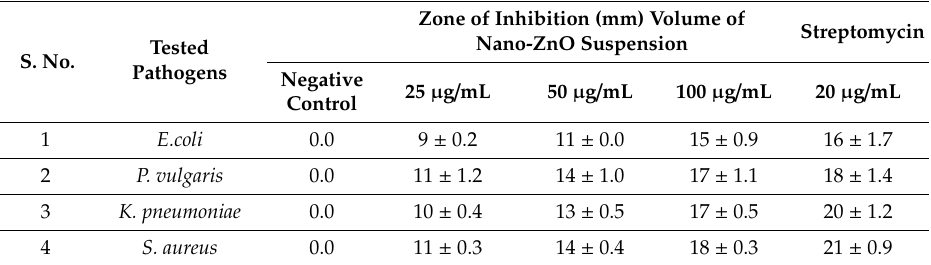
Table 1. Antimicrobial activity of green synthesized